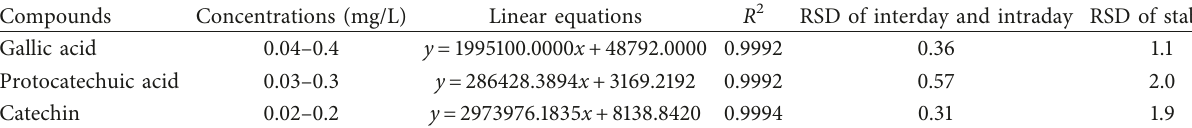
Table 3: The parameter optimization of method validation.